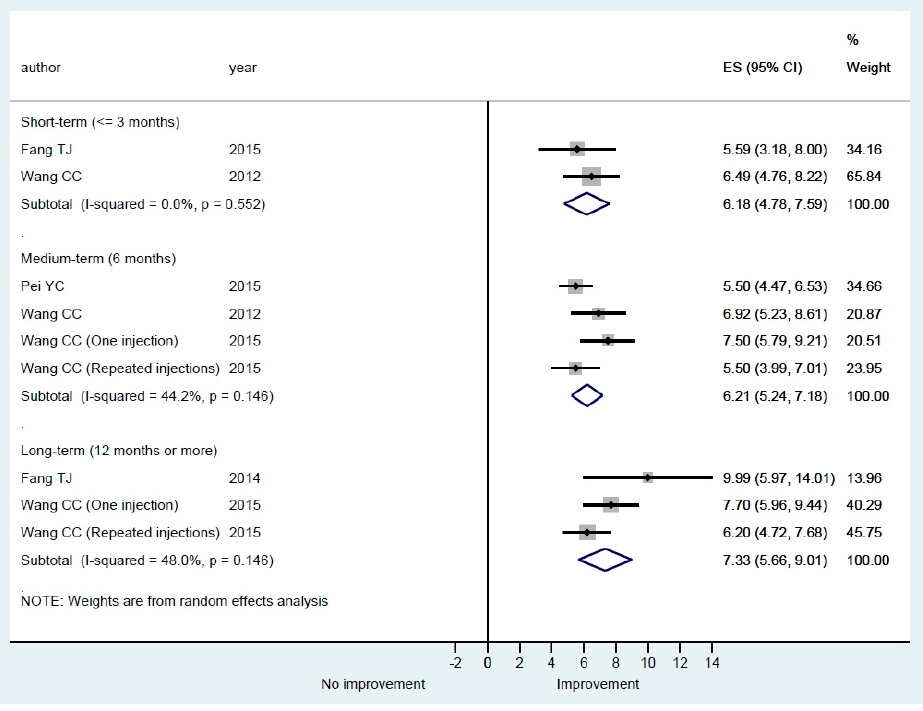
Figure 5. Subgroup meta-analysis regarding overall normalized glottal gap area (NGGA) in short-term, medium-term, and long-term follow-up after hyaluronic acid injection laryngoplasty.